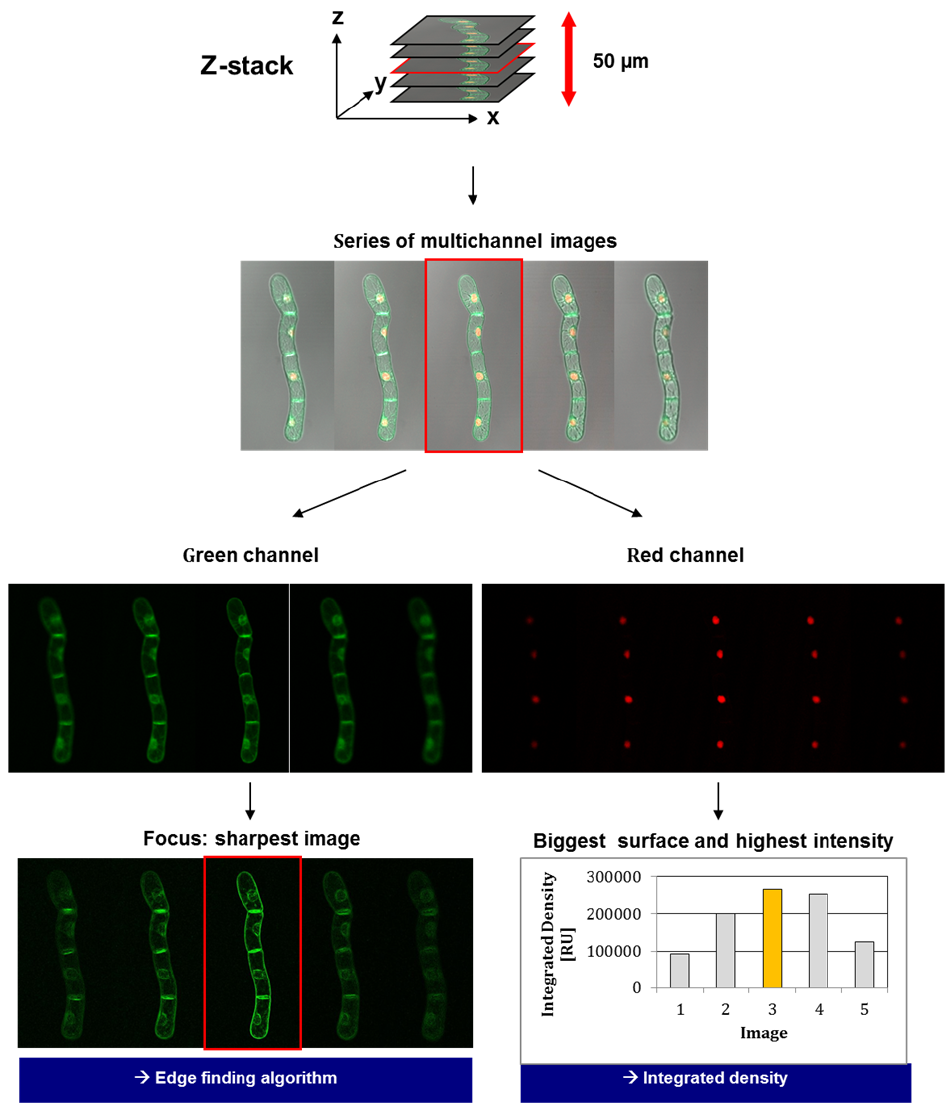
Figure 13. Correlation between the focal plane and the strongest signals in the red channel. Images are subsequently taken at different levels of the sample (Z-stack). The optimum sharpness of signals for RFP indicates the focus being set on nuclei. The determination of the sharpest image for the GFP signal provides an integrated optimum for the analysis of doubly transformed BY-2